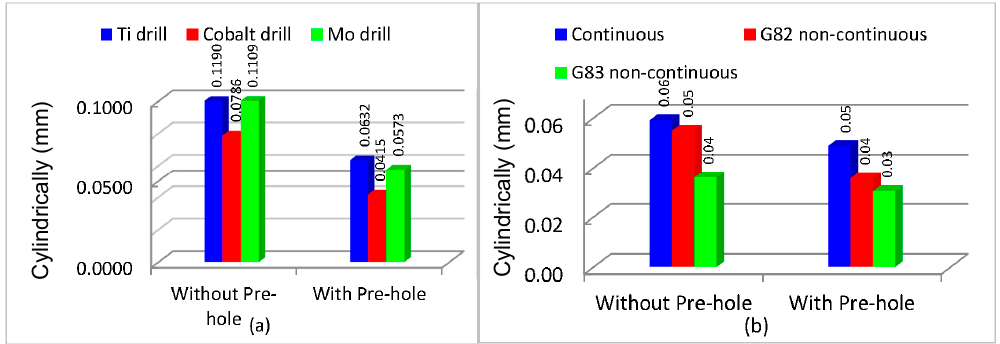
Figure 8. Cylindricity with and without a pre-center drill hole ( a ) for different cutters; ( b ) for various cutting strategies.